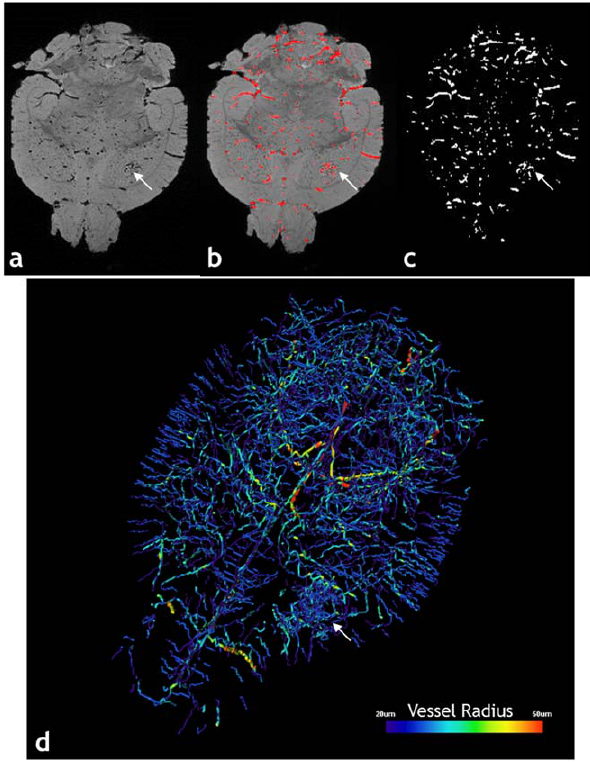
Figure 6. Segmentation of the Vasculature from m MRI Data. Image processing steps involved in the extraction of the 3D vasculature from the raw GE m MRI data for a 9L tumor (arrow in all panels) bearing mouse brain: (a) Ex vivo T 2 *-weighted image corresponding to the 1 st TE; (b) Blood vessels (red) segmented out using the ‘‘tubeness’’ filter overlaid on the raw data in (a). (c) Binarized vasculature obtained by thresholding the tubeness data in (b) followed by removal of isolated voxels. (d) Volume rendering of the m MRI-derived vasculature, color- coded by average vessel radius.